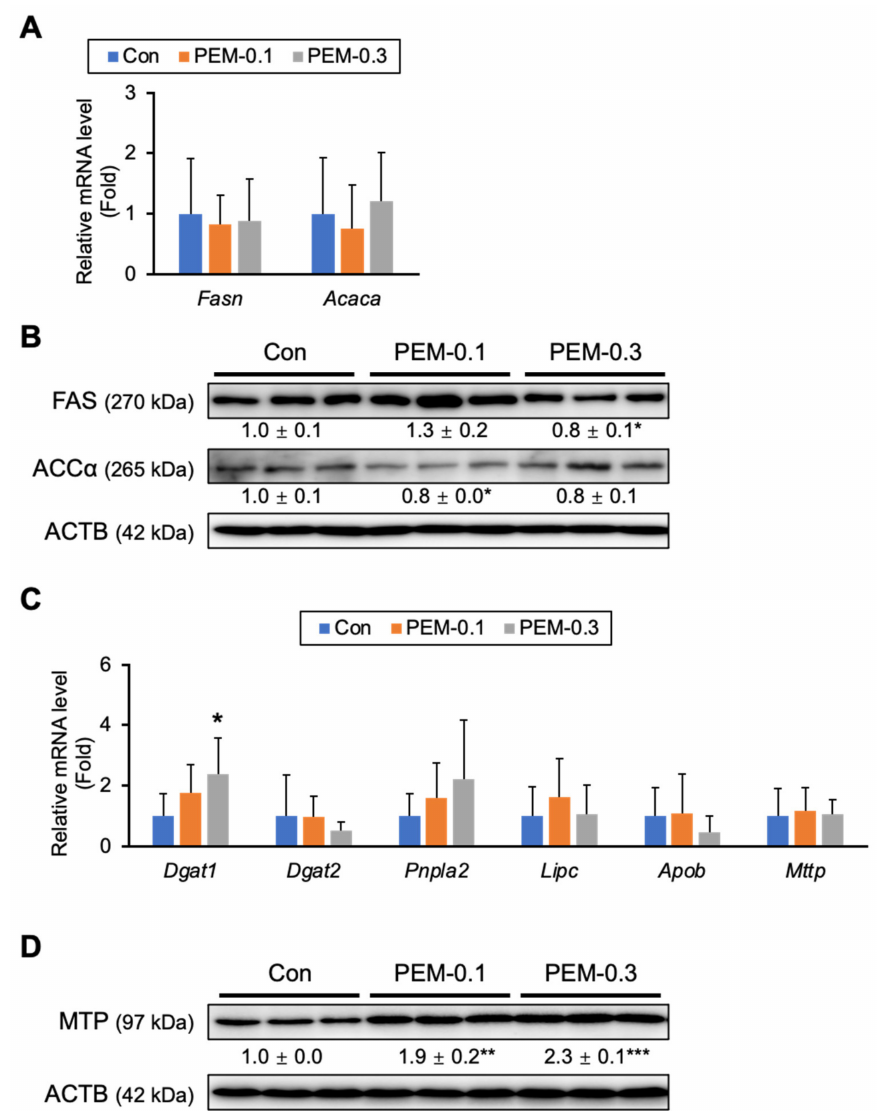
Figure 6. Effect of PEM on de novo FA synthesis, TG synthesis, and VLDL secretion. ( A , C ) Hepatic mRNA levels of genes related to FA de novo synthesis ( Fasn and Acaca ), TG synthesis ( Dgat1 and Dgat2 ), FA hydrolysis ( Pnpla2 and Lipc ), and FA secretion into the circulation ( Apob and Mttp ) were quantified by qPCR, normalized to that of 18s ribosomal RNA, and expressed as values relative to those of control mice. ( B , D ) Immunoblot analysis of FAS, ACC α , and MTP. ACTB was used as a loading control. Band intensity was measured densitometrically, normalized to that of ACTB, and expressed as values relative to those of control mice. Results were obtained from two independent immunoblot experiments. Data are expressed as the mean ± SD. * p < 0.05, ** p < 0.01, and *** p < 0.001 vs. control group. Con, vehicle-treated mice; PEM-0.1, pemafibrate-treated mice at a clinically relevant dose (0.1 mg/kg/day); PEM-0.3, pemafibrate-treated mice at a relatively high dose (0.3